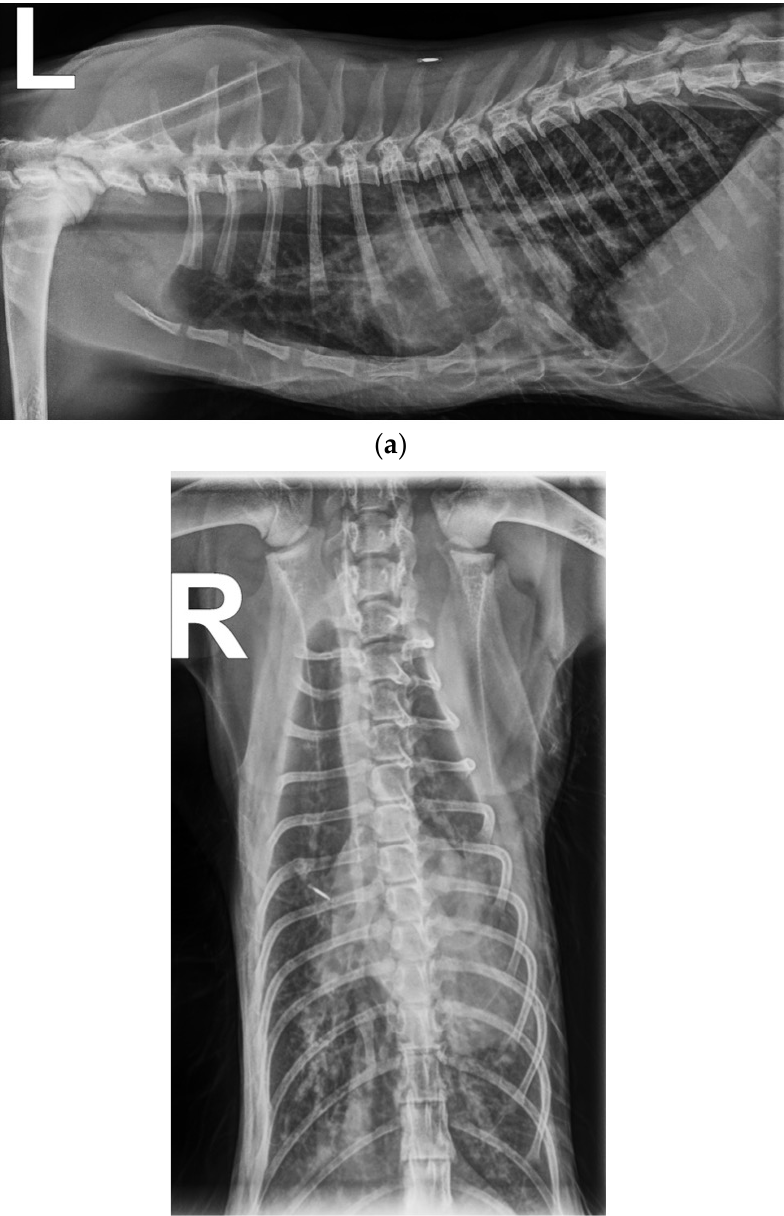
Figure 1. ( a , b ) Left lateral thoracic radiographs showing a generalized, unstructured interstitial pat- tern. The cat also had pectus excavatum, and the caudal sternum was dorsally deviating, displacing the cardiac silhouette to the left.